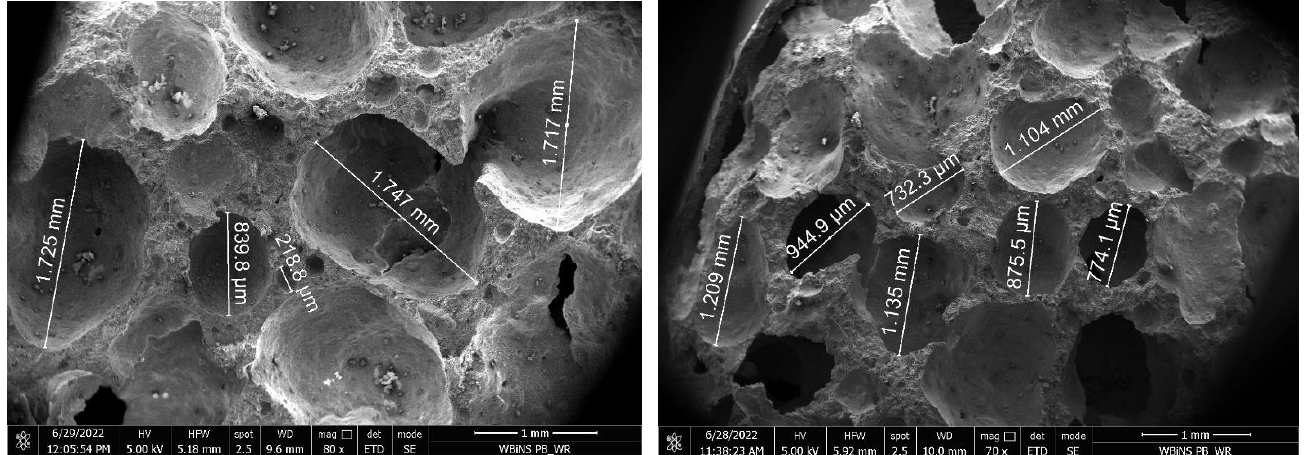
Figure 1. Large gas pores of ACC samples of different apparent density (450 kg/m 3 on the left and 600 kg/m 3 on the right) enclosed by the microporous skeleton of the material. 600 kg/m 3 on the right) enclosed by the microporous skeleton of the